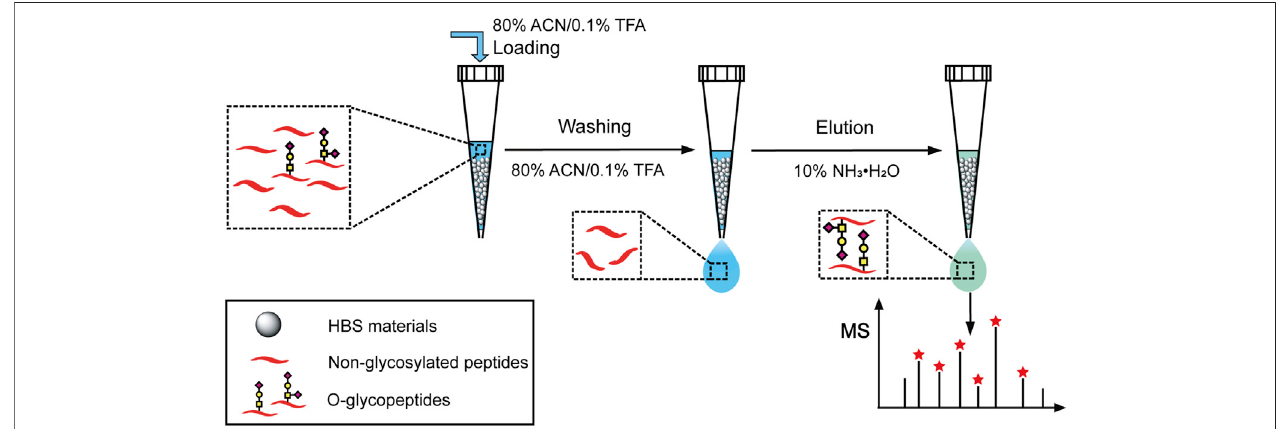
FIGURE 2 | Schematic illustration for the O-glycopeptide enrichment with the dual-functional histidine-bonded silica materials.